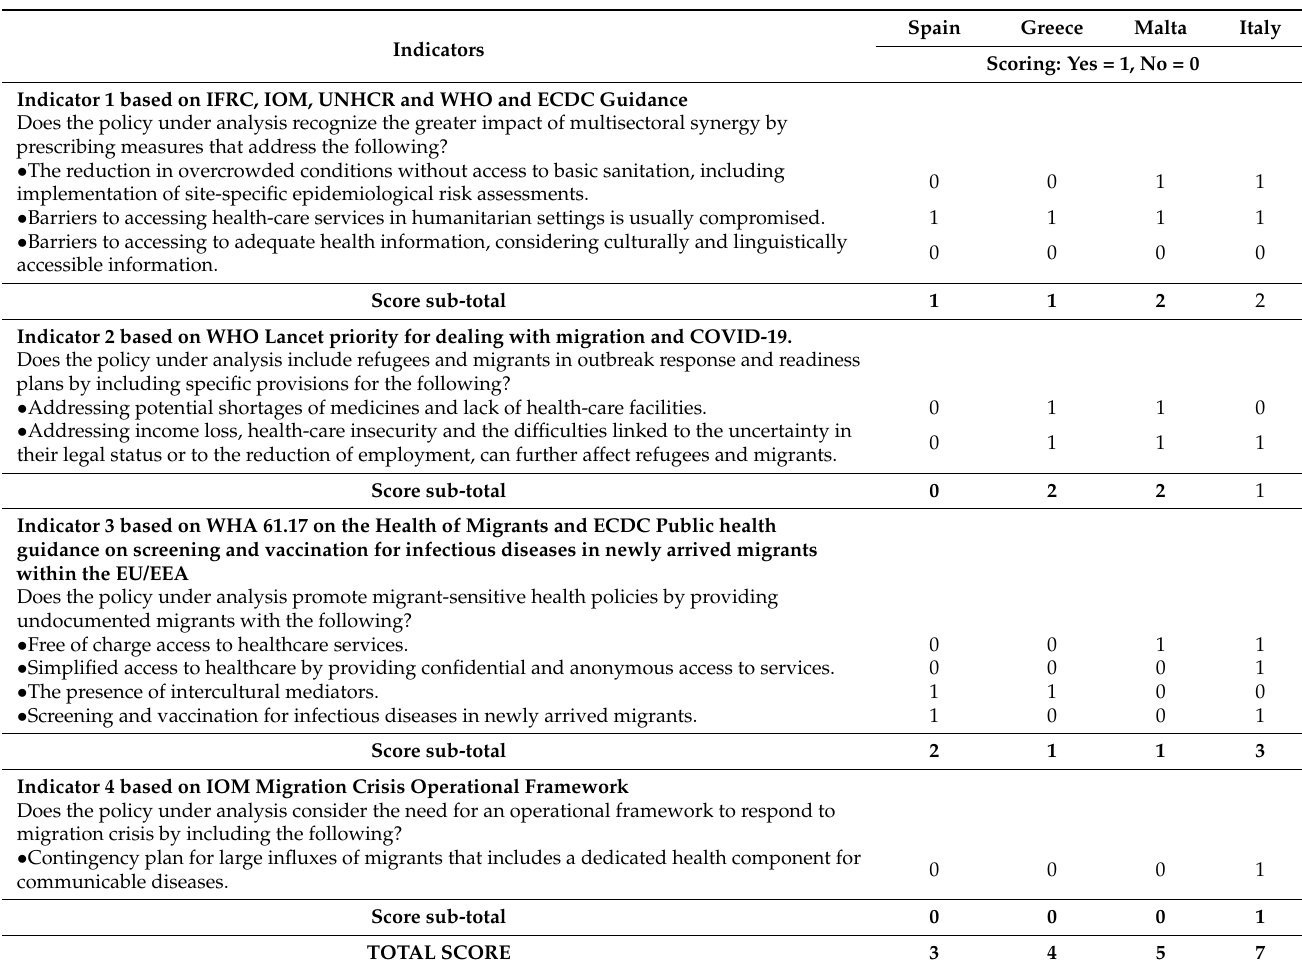
Table 5. Comparative